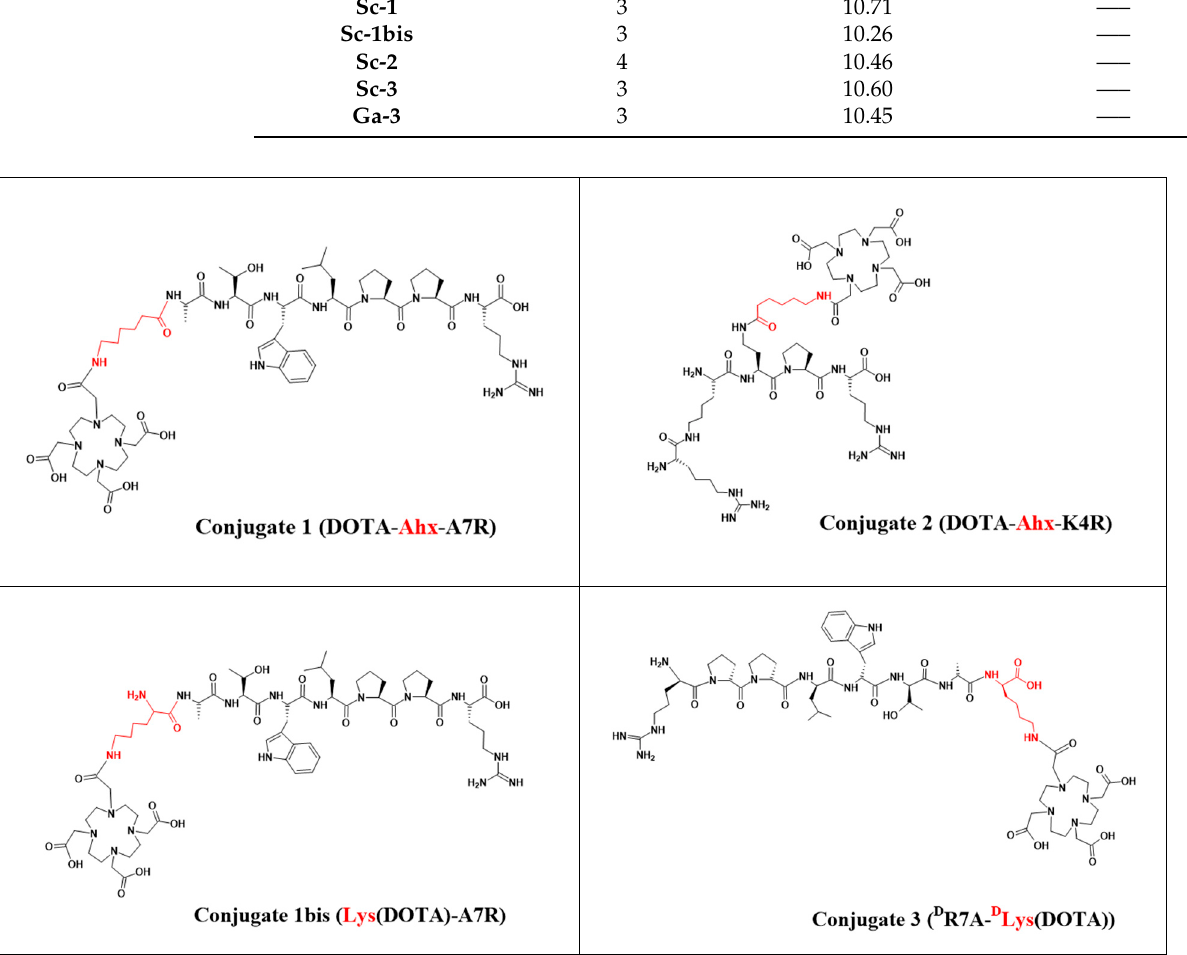
Figure 1. Chemical structure of the conjugates 1 , 1bis , 2 , and 3 . The linkers Ahx and Lys are marked in red.